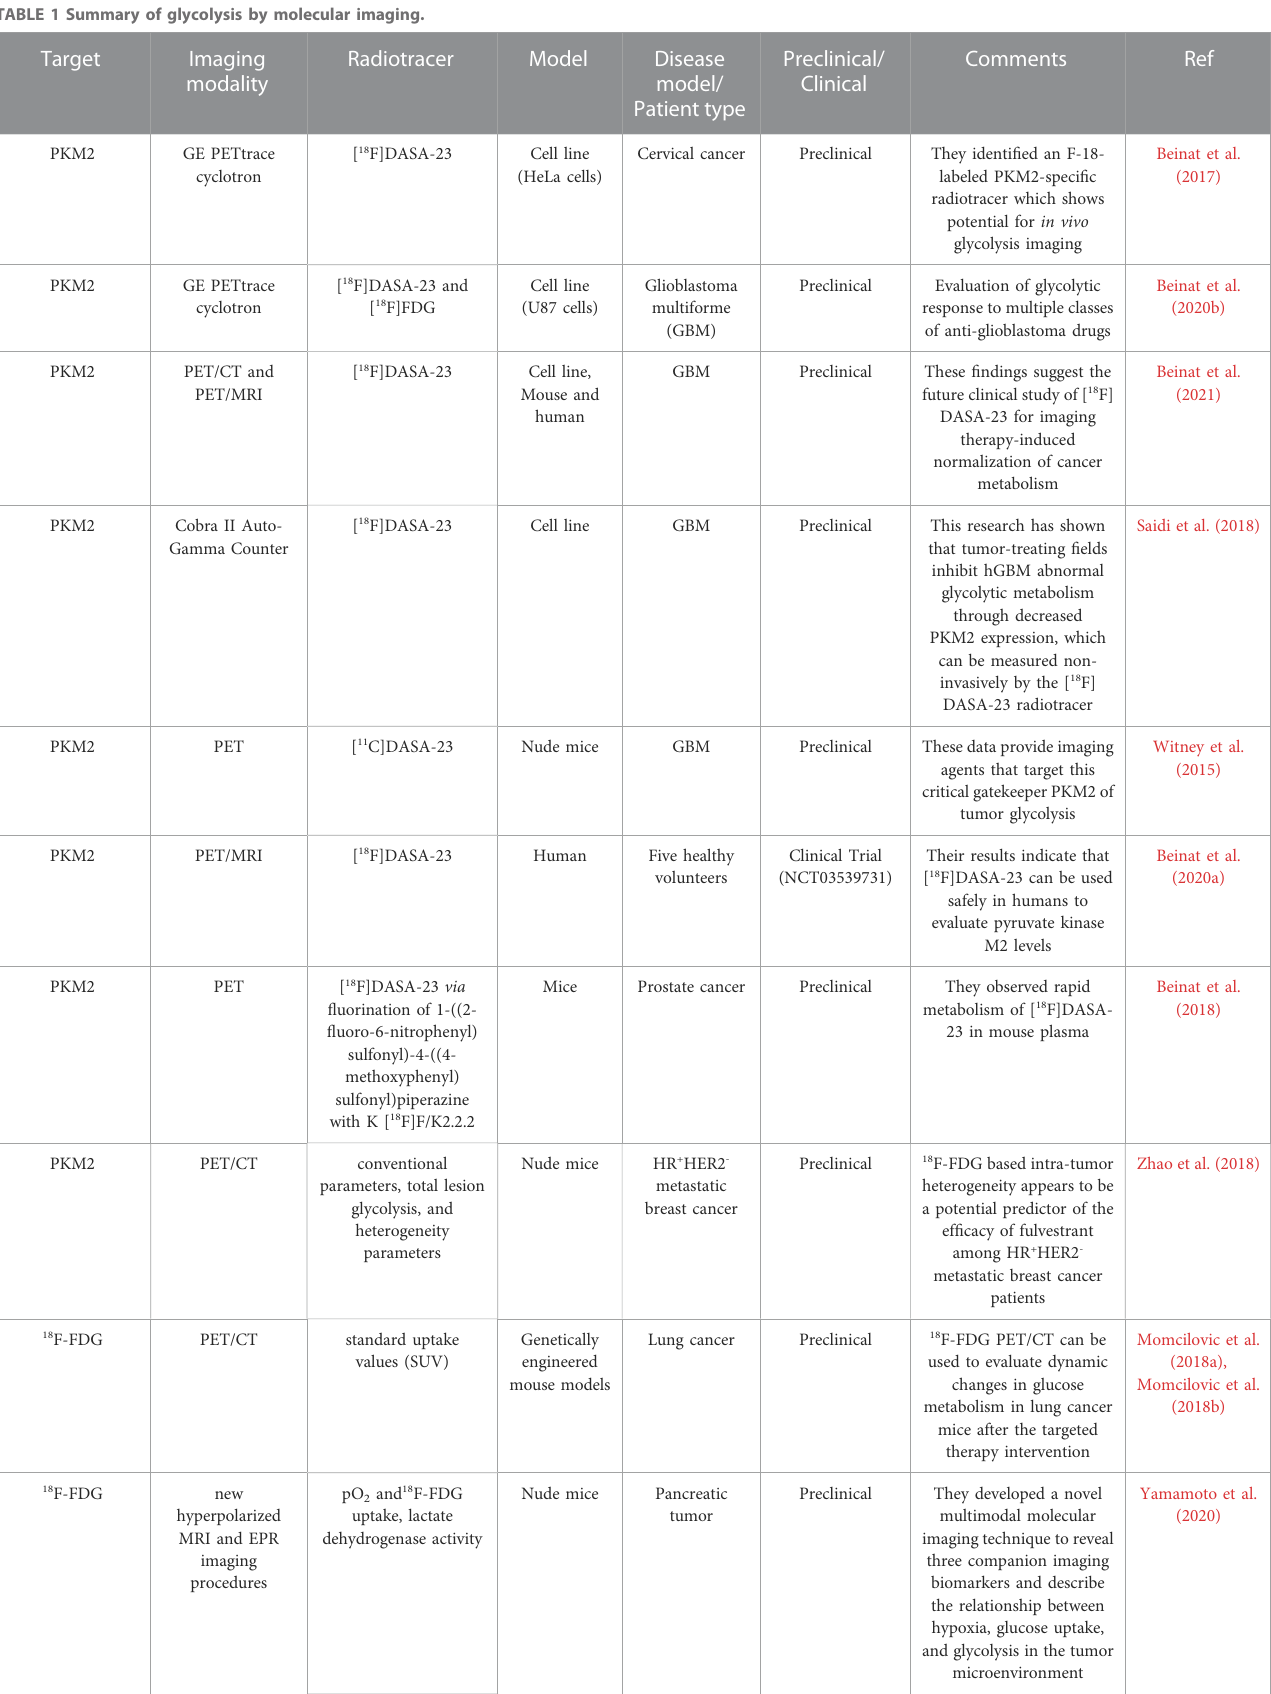
TABLE 1 Summary of glycolysis by molecular